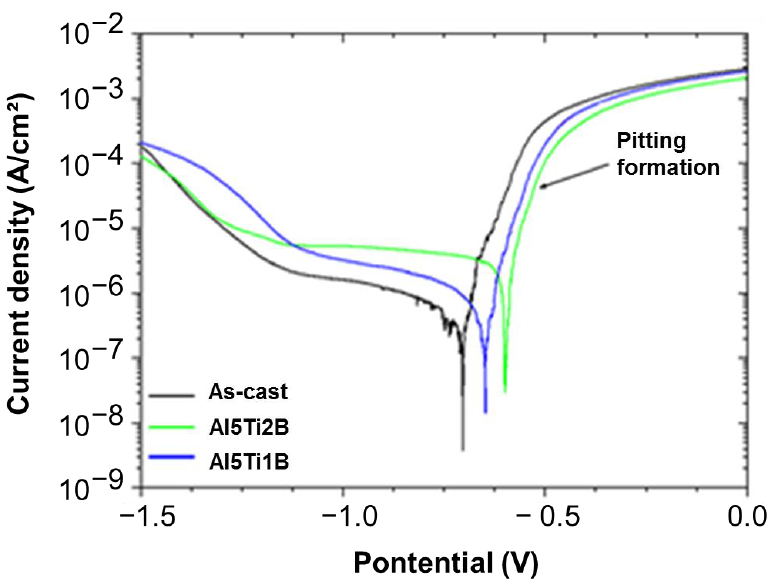
Figure 15. Tafel plots for the analyzed samples from as-cast condition without grain refiner; grain refiner Al5Ti2B; grain refiner Al5Ti1B.